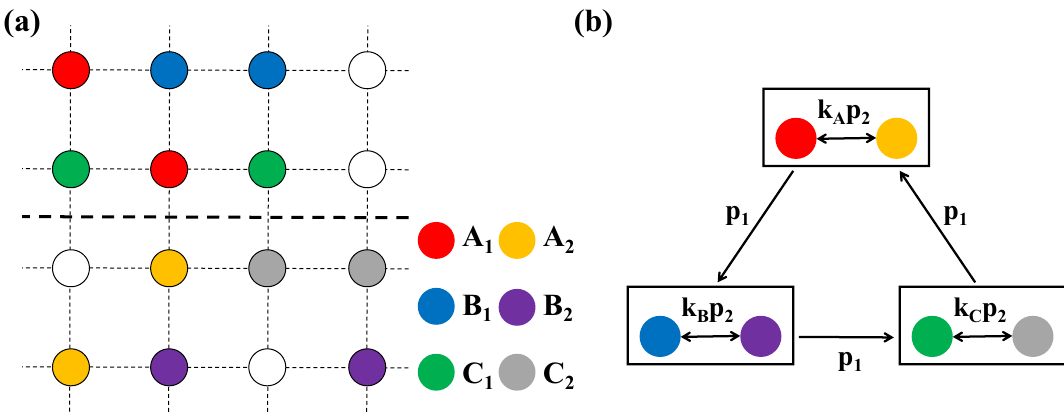
Figure 1. Schematic diagrams of network structure and the invasion rules among species. ( a ) Each circle represents a node, and individuals of species A , B , and C are evenly and randomly distributed on each node. To realize territorial awareness, the lattice is divided into two regions of equal size: the top and the bottom where the dashed line indicates the regional boundary. Two genera of the same species are distributed in different regions, and different color markers represent different species types. Nodes without color markers are empty nodes. ( b ) Interspecific interaction among three species A , B , and C (indicated by three boxes) occurs cyclically with a rate p 1 . A box of each group describes the intraspecific interaction between individuals who belong to different territories where the interaction is regulated by territorial consciousness. Here intraspecific interaction in each group occurs with a rate k i · p 2 ( i ∈ { A , B , C }